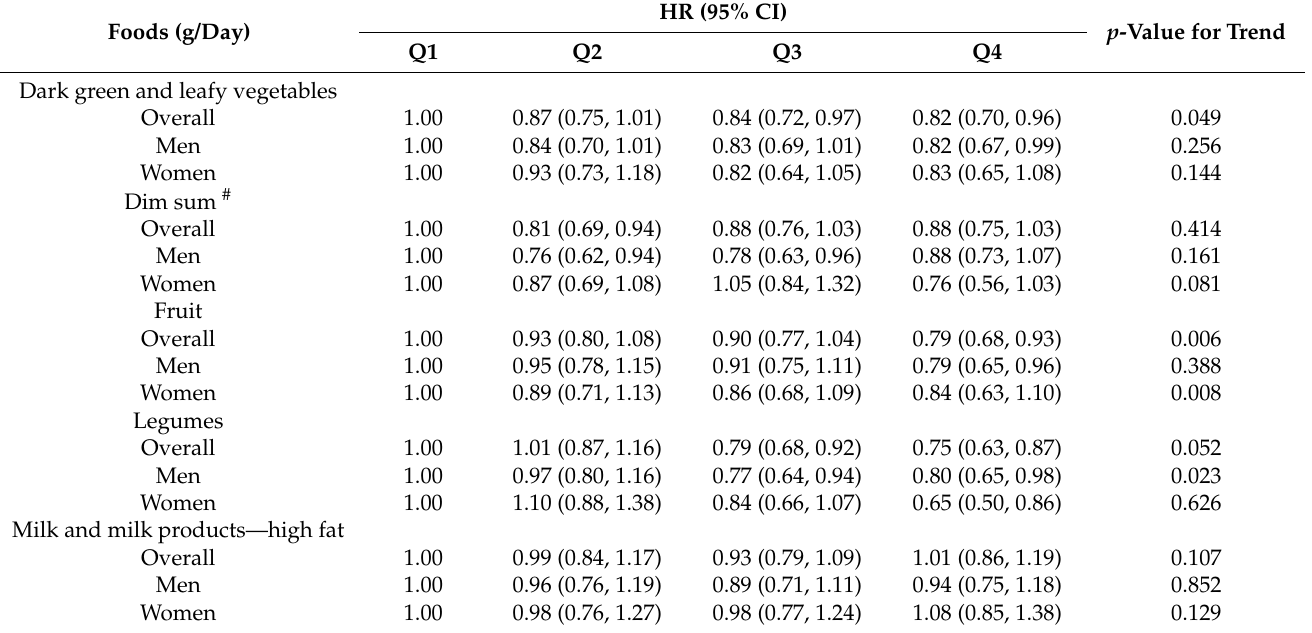
Table 2. Prospective association of quartile (Q) of food groups with an all-cause mortality risk selected by elastic net regression among participants in the Mr. OS and Ms. OS